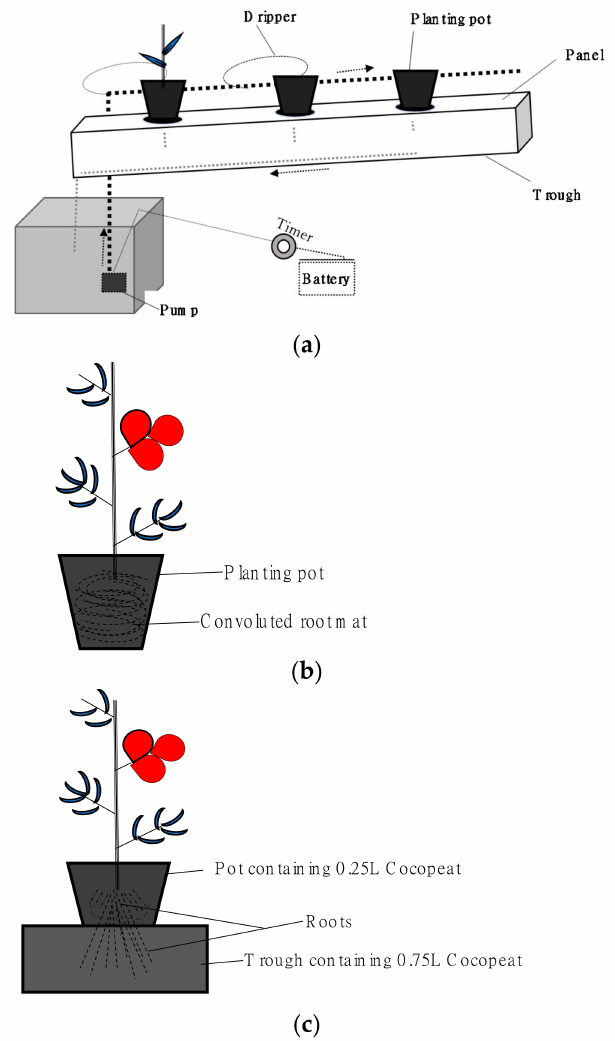
Figure 1. ( a ) Recirculating hydroponic system, ( b ) complete root restriction in 1.0–1.5 L pot, and ( c ) Partial root restriction in Cocowool (0.25 L pot + 0.75 L